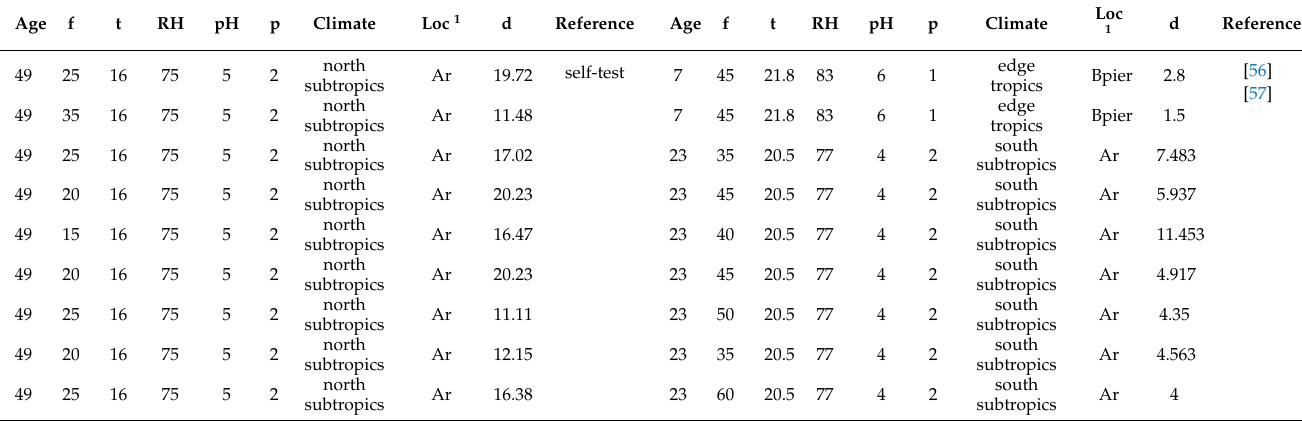
Table A1. Detailed information of 448 sets of